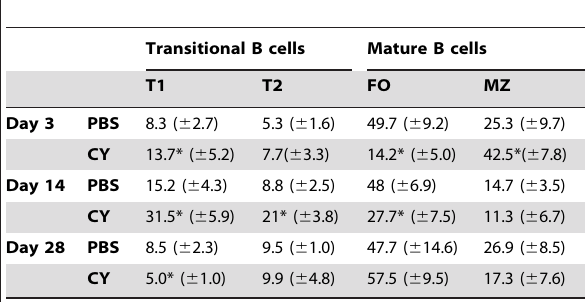
Table 3. Percentage of splenic B cells of R4A Tg mice following treatment with